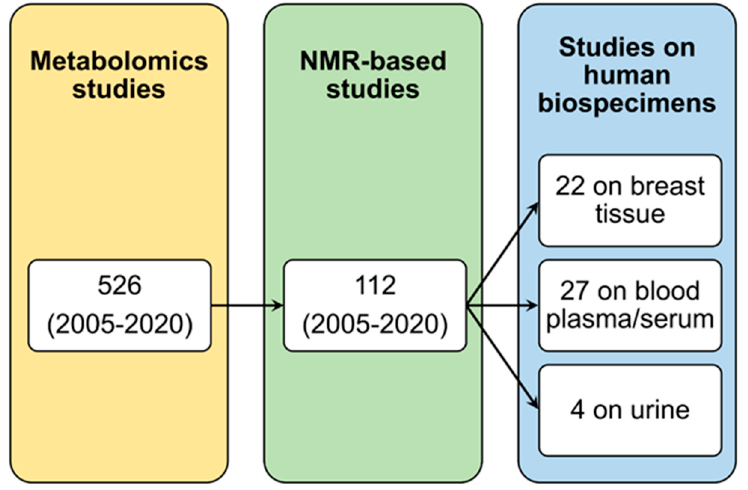
Figure 2. Selection of the scientific articles included in this NMR-based metabolomics review. The figure shows the workflow of the papers’ selection. Table 1. List of evaluated publications.